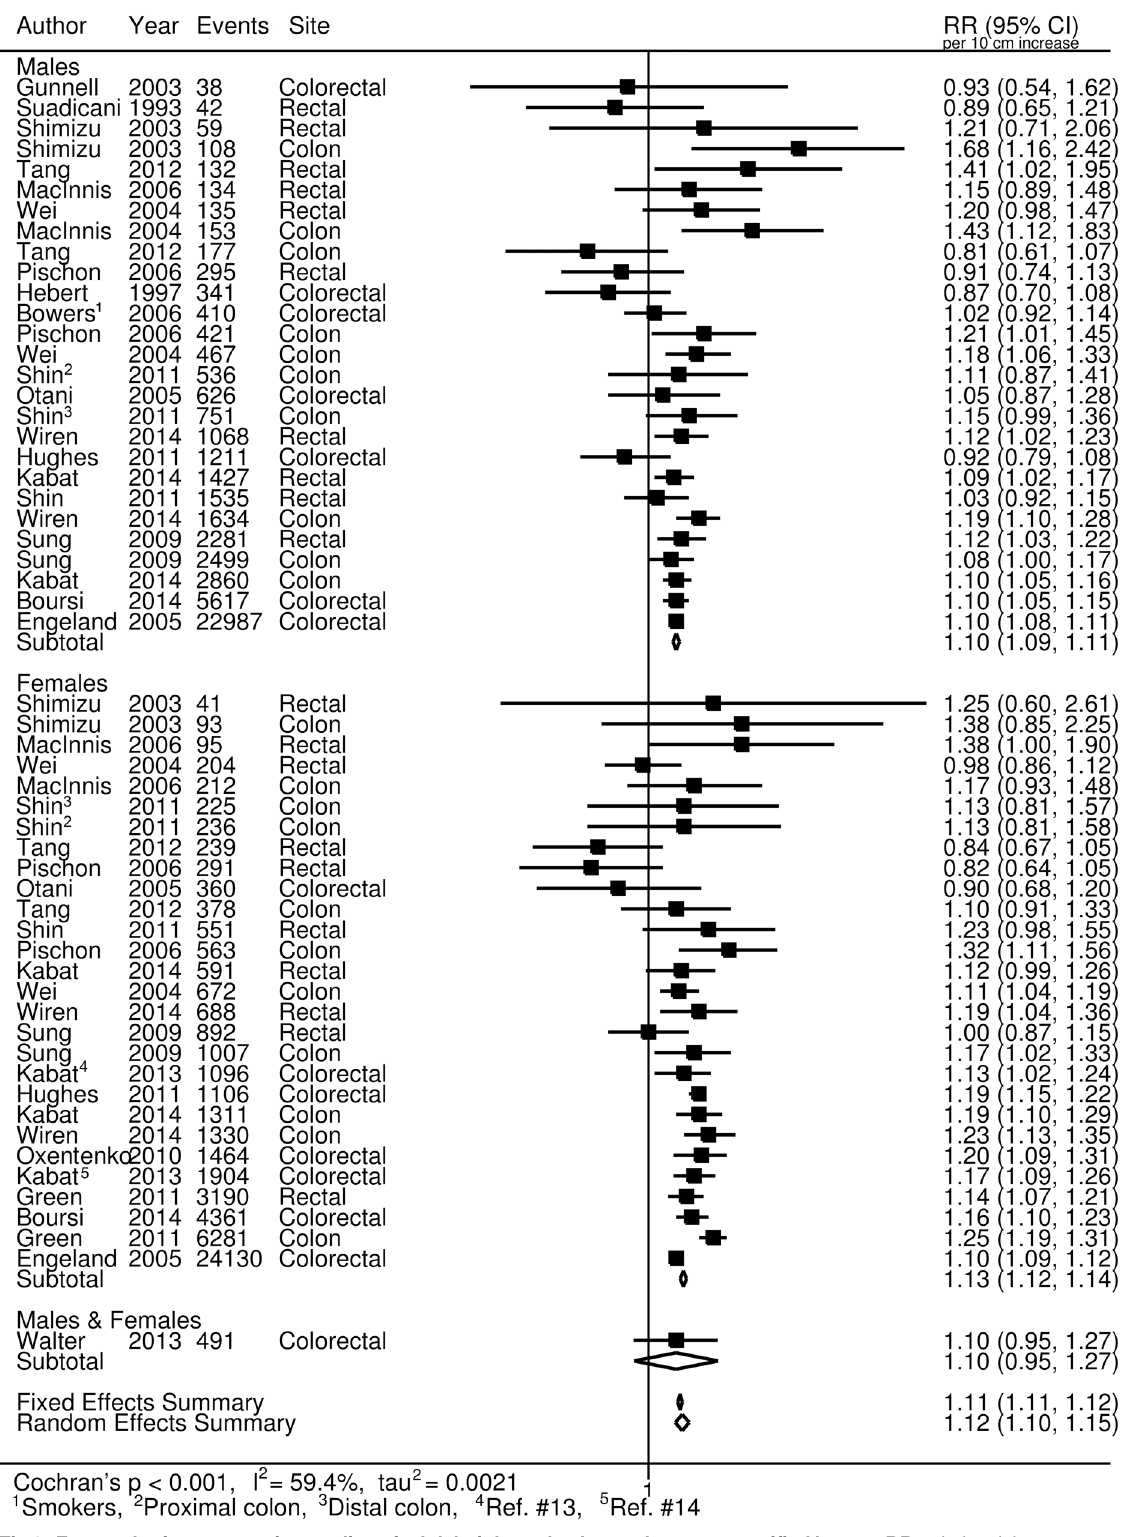
Fig 2. Forest plot for prospective studies of adult height and colorectal cancer, stratified by sex. RR, relative risk.